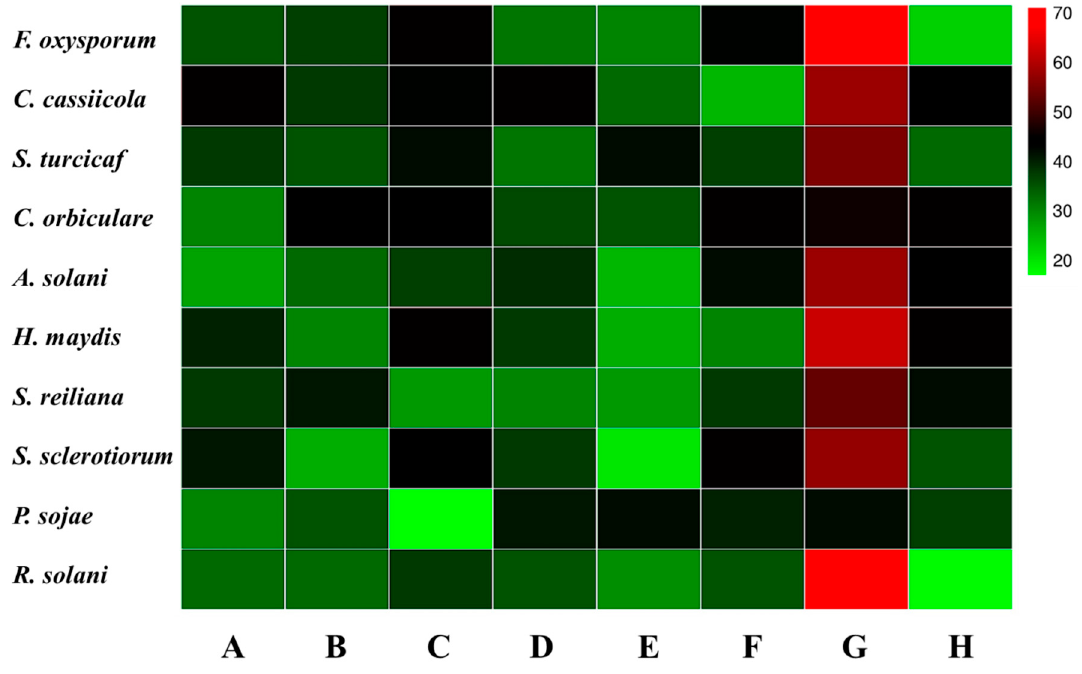
Figure 5. Eight isolates showed antagonism to Fusarium oxysporum f. sp . cucumerinum and nine other pathogenic fungi. A , HGS1-1; B , HGS2-18; C , HGS3-17; D , HAAG3-4; E , HAAG3-8; F , HCPA2-26; G , HAAG3-15; H , DCPA1-15. The color of the checkerboard represents the inhibition rate of fungal mycelial growth (%) of A–H. The legend on the right side represents the color corresponding to the different inhibition rates.